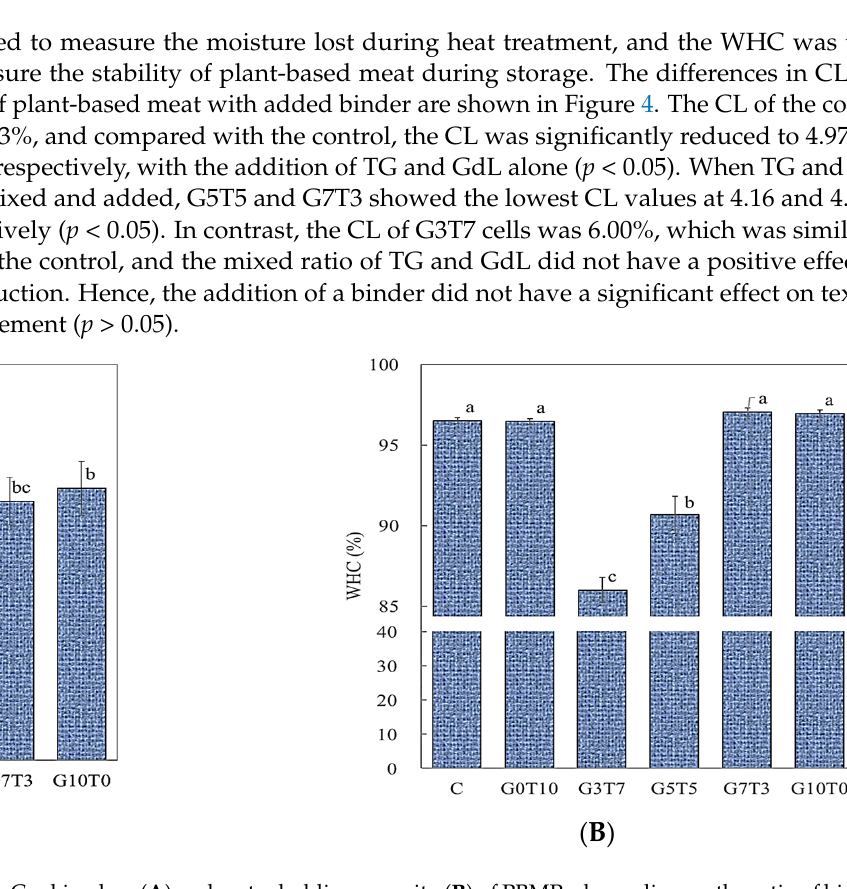
Figure 4. Cooking loss ( A ) and water holding capacity ( B ) of PBMPs depending on the ratio of binders. C, control; G0T10, GdL:TG = 0:10; G3T7, GdL:TG = 3:7; G5T5, GdL:TG = 5:5; G7T3, GdL:TG = 7:3; G10T0, GdL:TG = 10:0. a–c indicate that different superscripts in a column are statistically significant differences ( p <